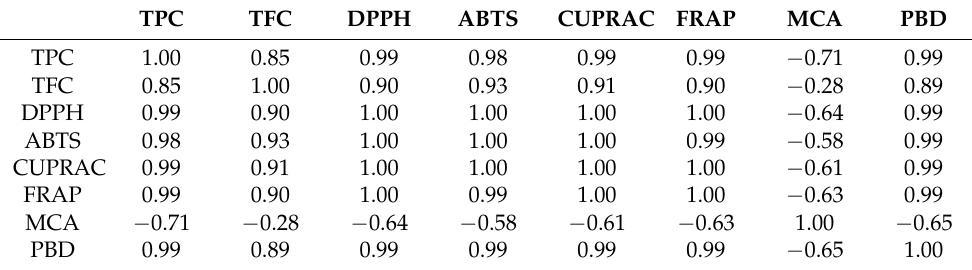
Table 5. Pearson’s correlation (R) values between total phenolic, flavonoid content, and antioxidant assays.